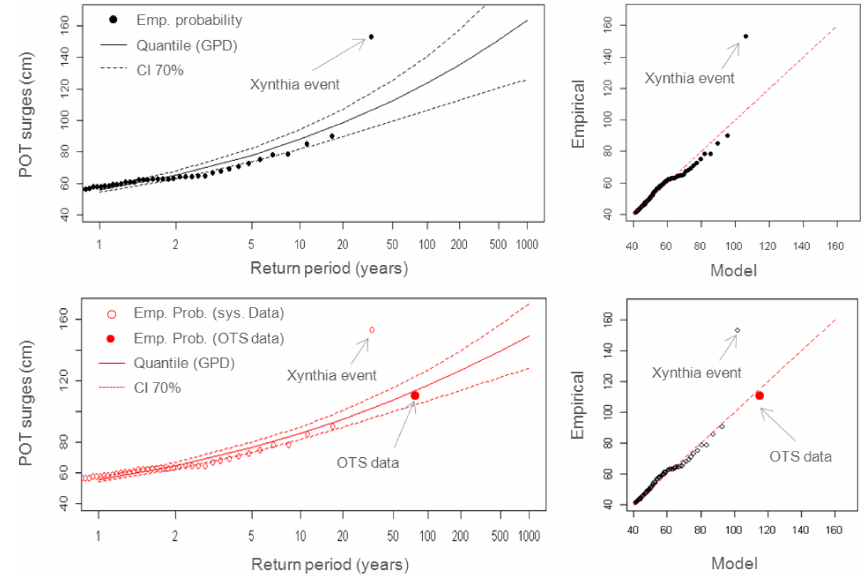
Figure 8. The GP distribution fitted to the POT surges at the La Rochelle station: with no historical information included (top left panel) and the corresponding Q–Q plot (top right panel); with both systematic and historical data (bottom left panel) and the corresponding Q–Q plot (bottom right